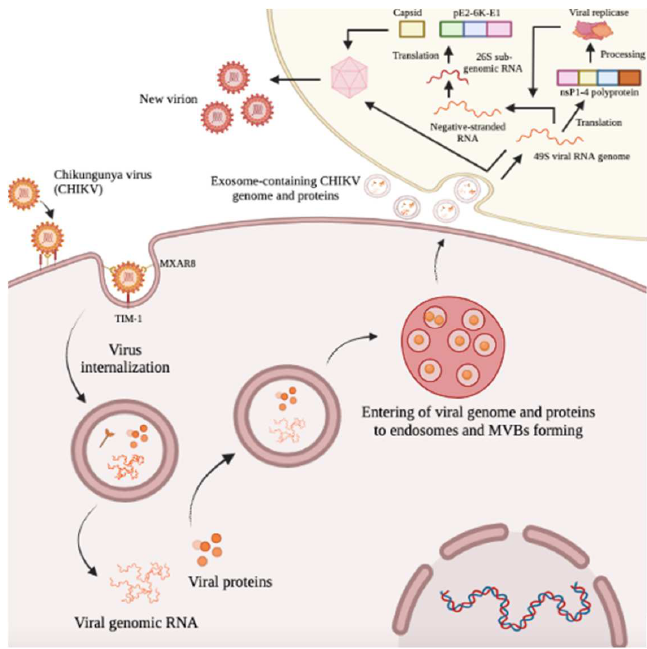
Figure 6. Schematic model of the involvement of exosomes during CHIKV infection. Visual representation of exosomes from CHIKV-infected epithelial cells participate in the Cell−to−Cell transmission of infectious viral elements. Figure created with the BioRender software (https://biorender.com/ accessed on 4 September 2022).